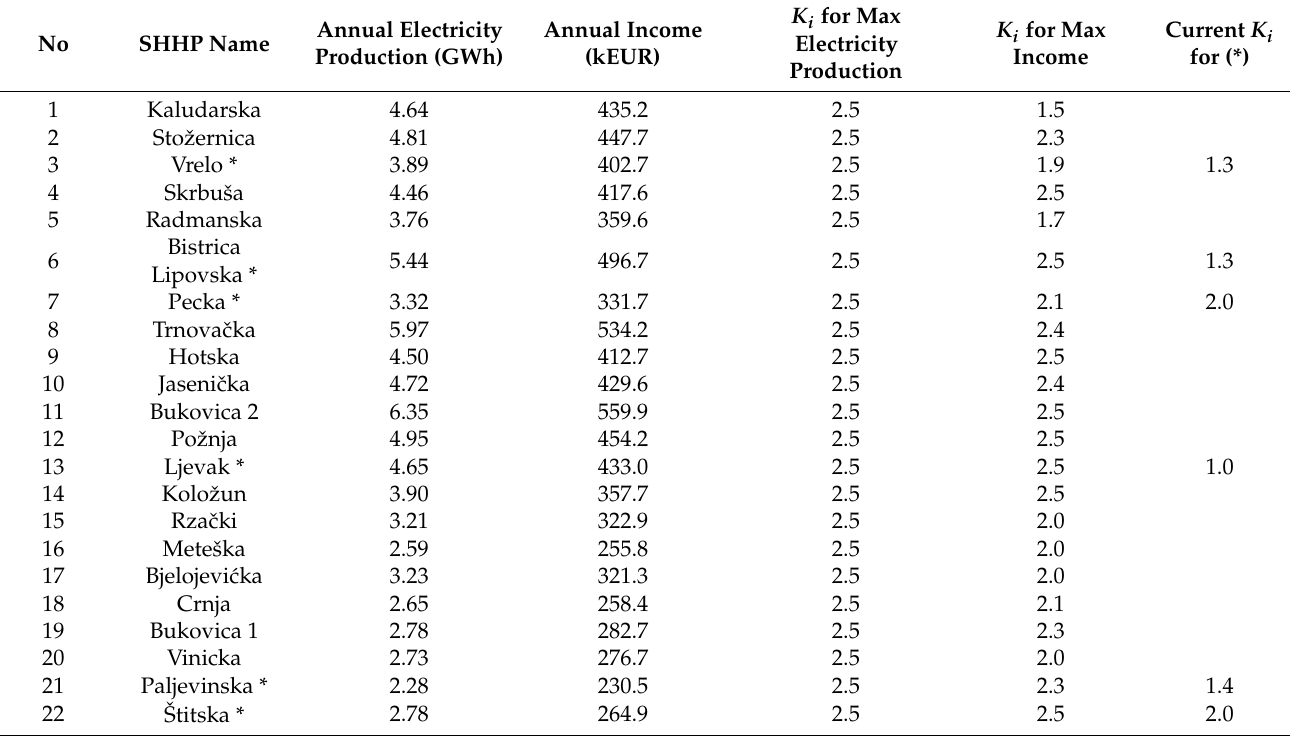
Table 6. Maximum annual production and income and corresponding SHPP installed parameter for SHPPs from 0.4 MW to 2.4 MW—Group II, (*—constructed plants).